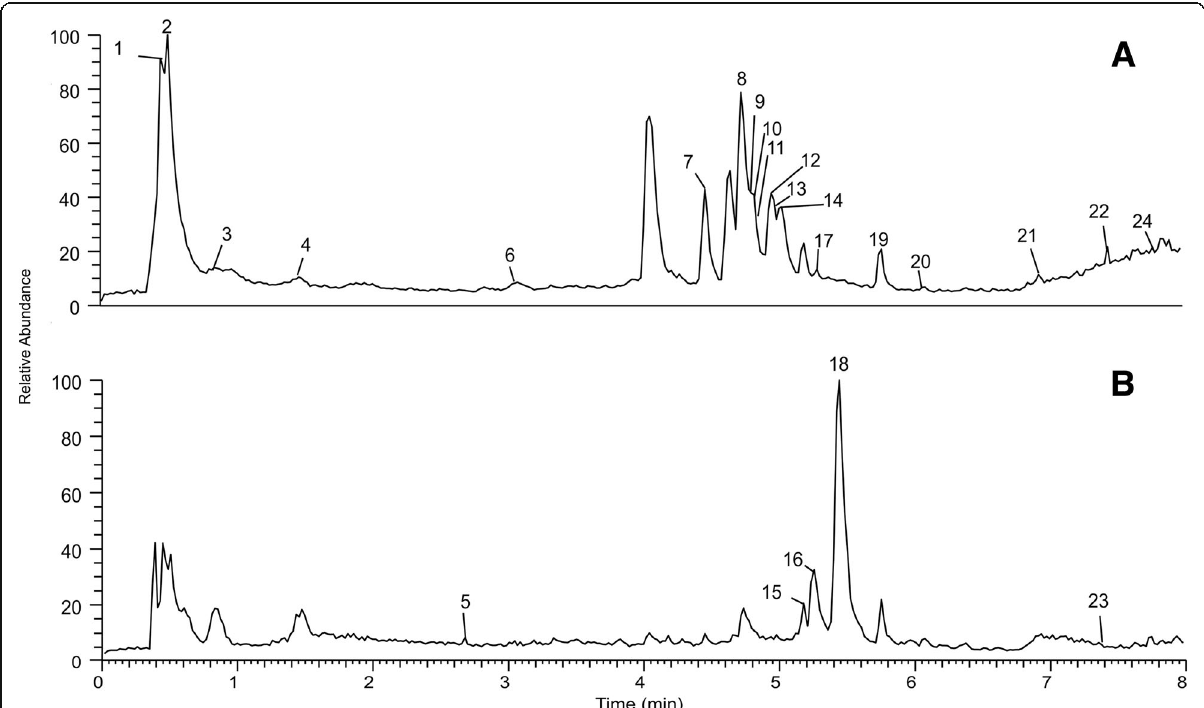
Fig. 2 Fingerprinting of freeze-dried CPLJ by UPLC-HRAMS analysis. Chromatograms of freeze-dried CPLJ was generated by UHPLC-ESI-Orbitrap- MS/MS at ( a ) negative and ( b ) positive